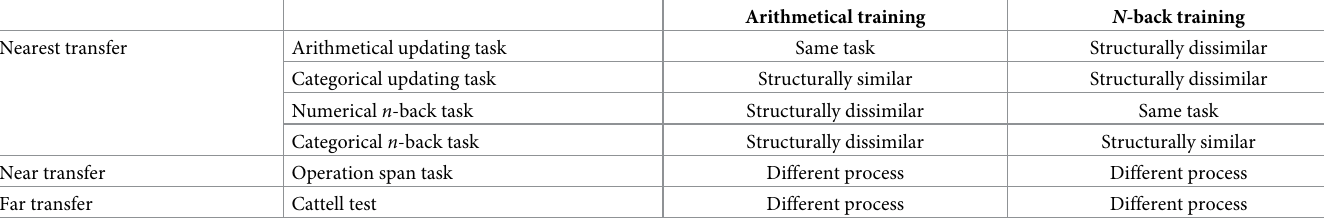
Table 1. Transfer tasks classified by type of transfer and degree of structural similarity, for each training